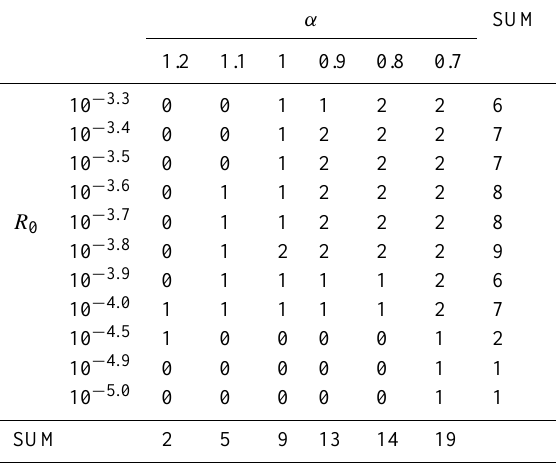
Table 9. Final scorecard for all R 0 and α pairs and for all experi- mental